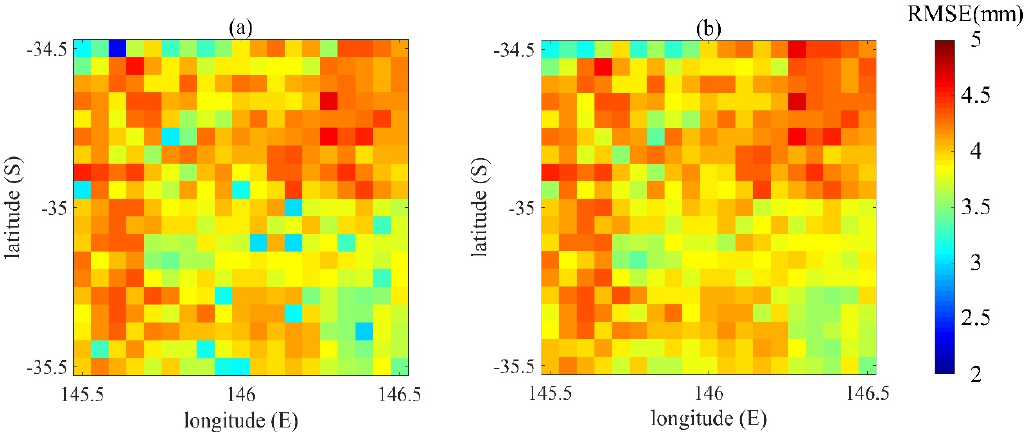
Figure 8. The RMSE between the CCI data and assimilated data using: ( a ) the BGM method; and ( b ) the Monte Carlo (MC) method.